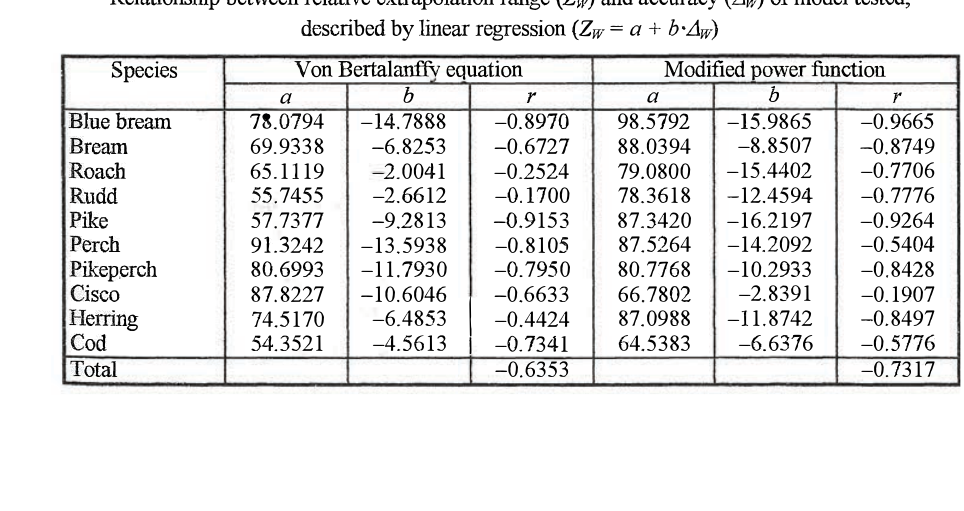
Relationship between relative extrapolation range (Zw) and accuracy (Llw) of model tested, described by linear regression (Z w = a